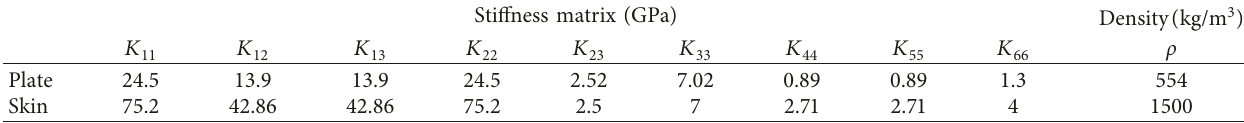
Table 2: Equivalent stiffness and density of the homogenized plates.